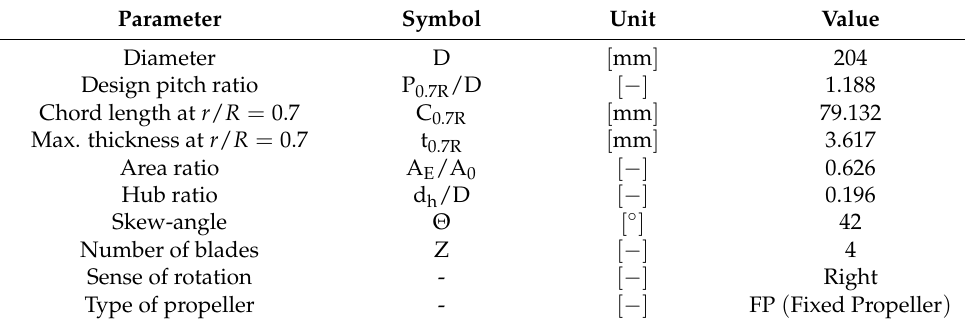
Table 3. P1595. Main geometric